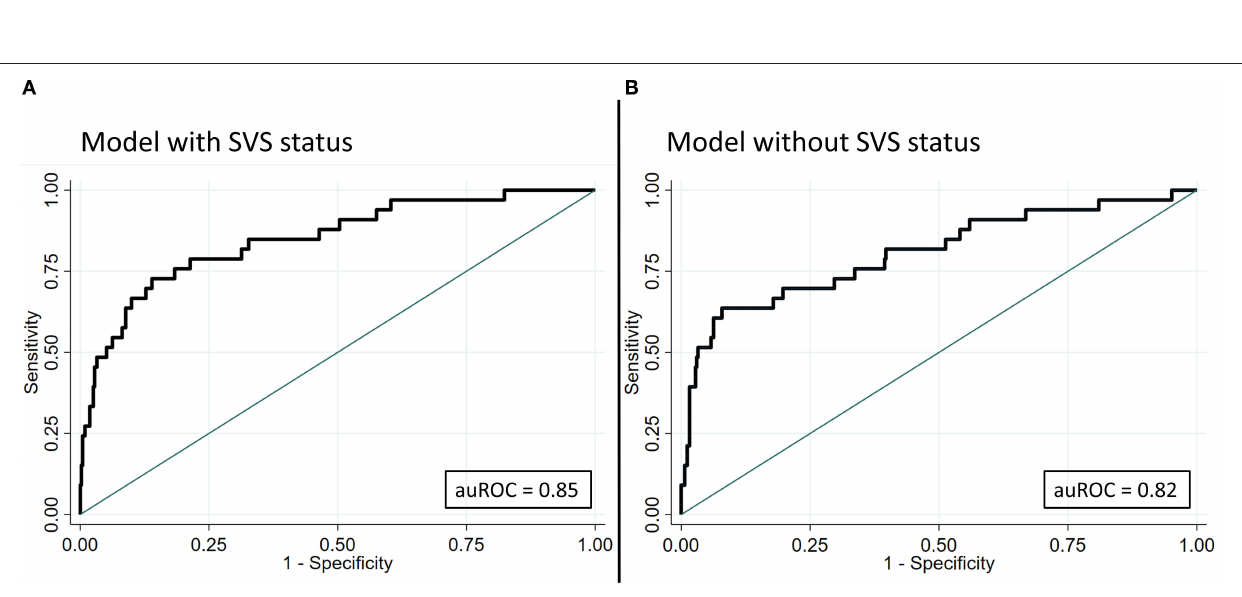
Frontiers in Neurology |